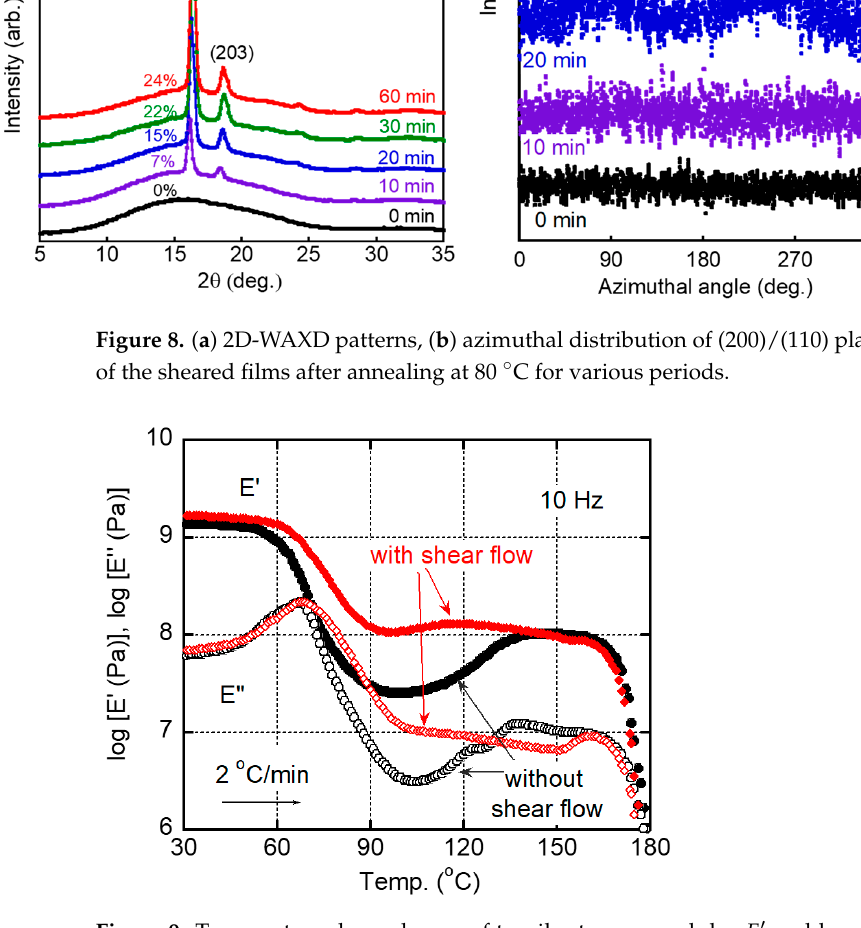
Figure 9. Temperature dependences of tensile storage modulus E ′ and loss modulus E ″ at 10 Hz for the films with/without shear history after annealing at 80 °C for 60 min. The heating rate was 2 °C/min.